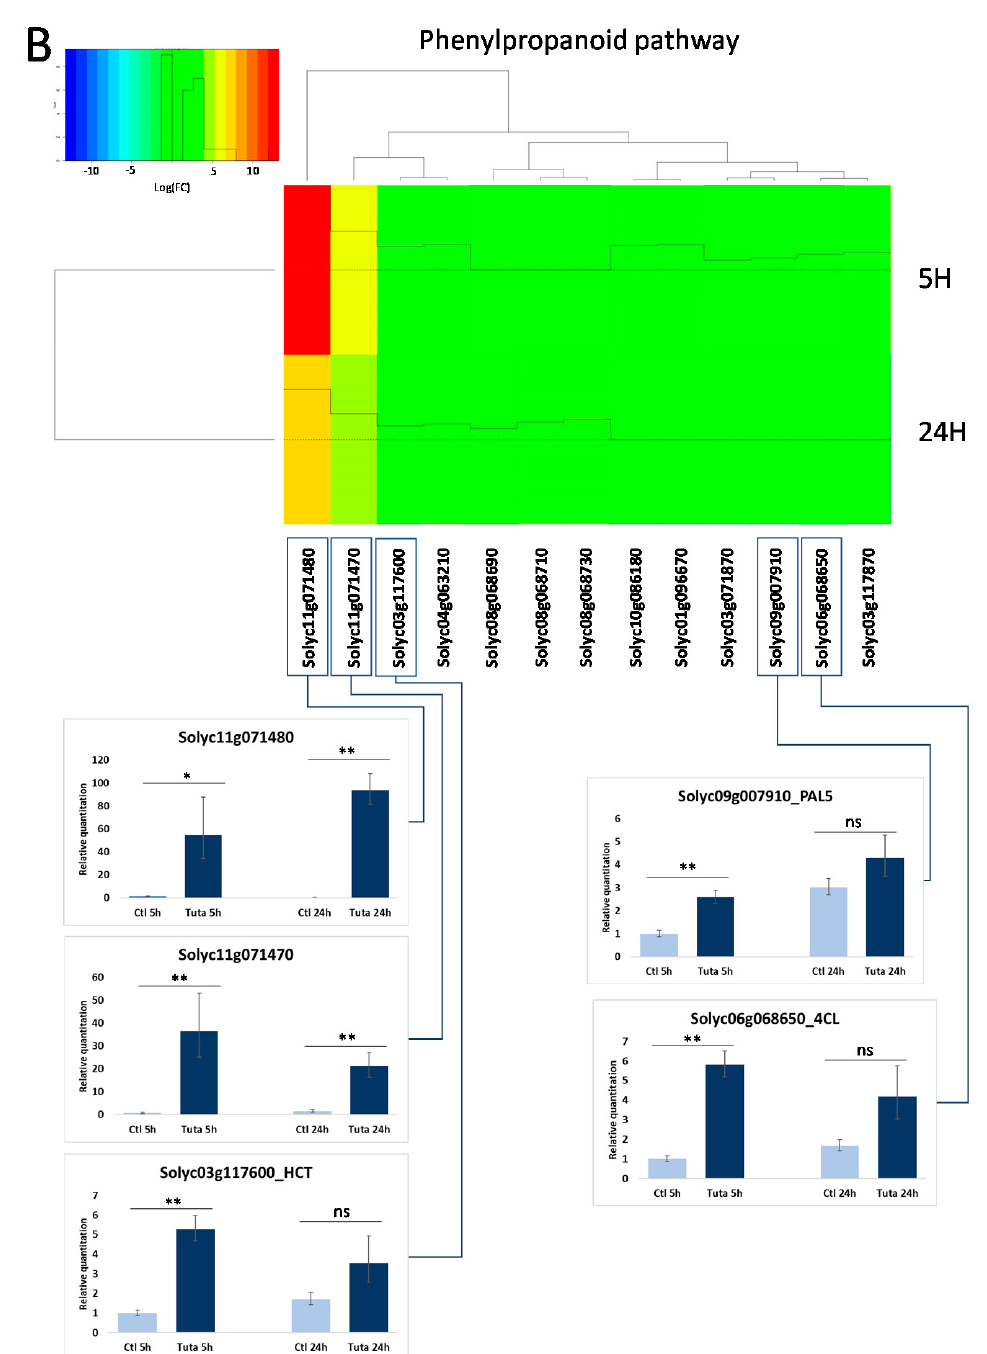
Figure 5. Expression level of selected genes representing key steps in the polyamine ( A ) and phenylpropanoid ( B ) pathways. The heatmap represents the differential expression measured from the RNAseq analysis, between control and T. absoluta infested leaf at 5 h and 24 h. In addition, the expression level of several genes was measured by real-time PCR on cDNA prepared from leaves corresponding to the 4 conditions (control and T. absoluta infested after 5 h and 24 h). Statistical significance is indicated by * ( p < 0.05), ** ( p < 0.01) and *** ( p < 0.001). ns means non significant.